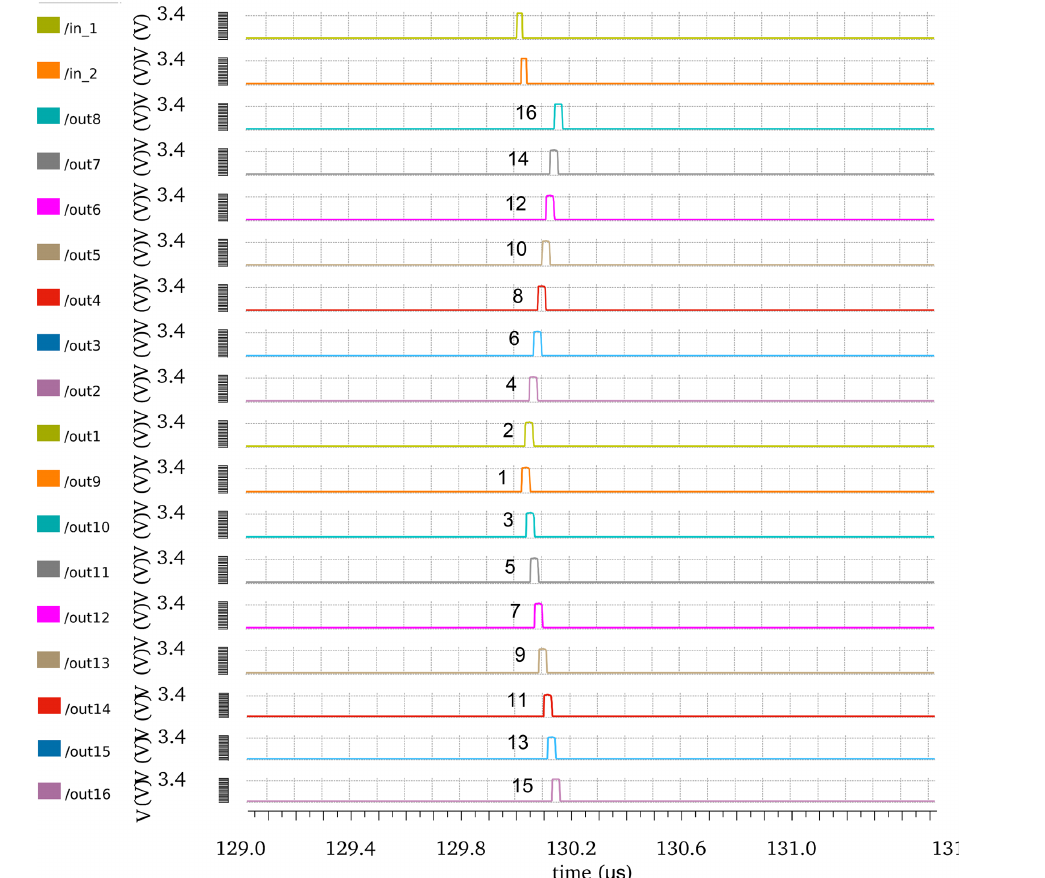
Figure 21. Simulation of the ASRC, with a difference of 15ns between in1 and in2. They are coded by spike order codes.